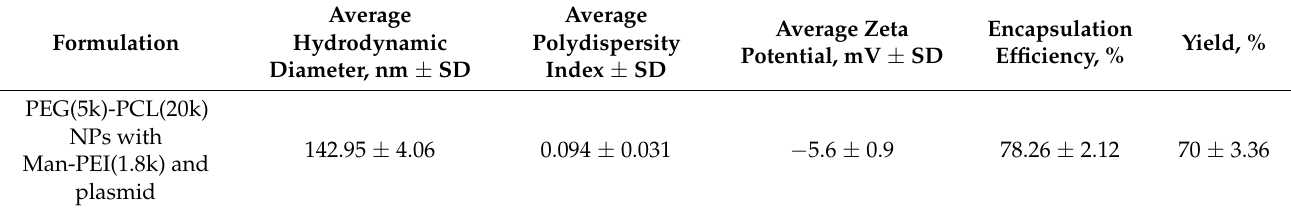
Figure 7. PEG-PCL NPs with encapsulated Man-PEI/plasmid complexes present nanosized spherical structures of relatively similar size and minimal toxicity. ( a ) Representative SEM imaging of the polymer nanocarriers; ( b ) Dynamic Light Scattering analysis of the nanoparticles; ( c ) Zeta-potential analysis of the nanocarriers; ( d ) Cytotoxicity analysis of PEG-PCL NPs with encapsulated Man-PEI/plasmid complexes in SW480 and HCT-15 cells. Table 1. Nanoparticle